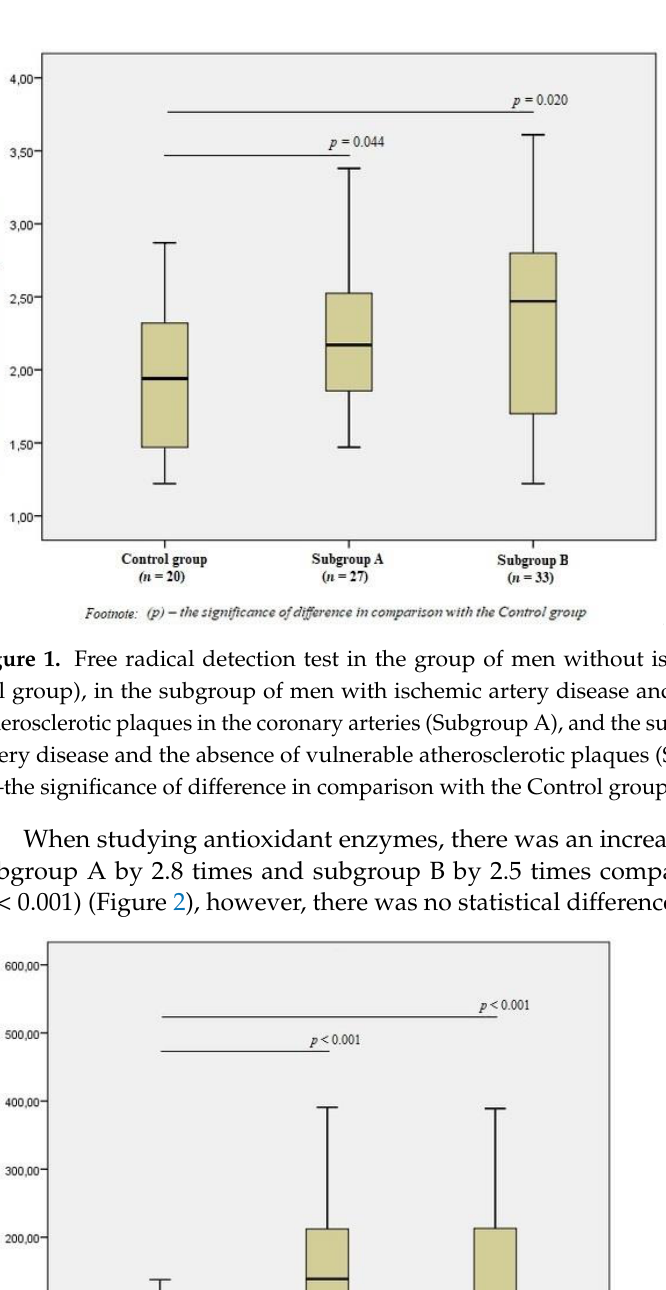
Figure 3. The blood catalase levels in the group of men without ischemic artery disease (Control group), in the subgroup of men with ischemic artery disease and the presence of vulnerable ather- osclerotic plaques in the coronary arteries (Subgroup A) and the subgroup of men with ischemic artery disease and the absence of vulnerable atherosclerotic plaques (Subgroup B), Me (25%; 75%). p — the significance of difference in comparison with the Control group.